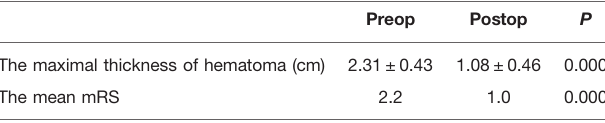
TABLE 2 | Result of radiological and clinical outcomes ( N =49 patients). Preop Postop